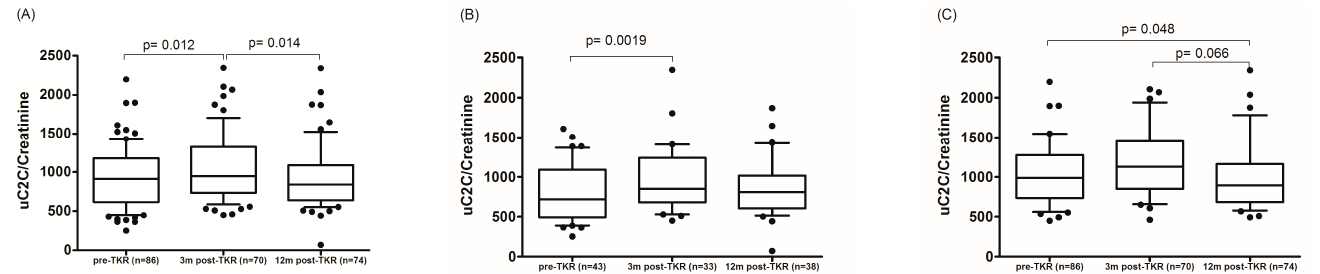
Figure 3. The dynamics of uC2C before and 3 or 12 months after TKR in ( A ) the whole group, ( B ) males, and ( C ) females (boxplot with 10th–90th percentiles, Wilcoxon paired test).